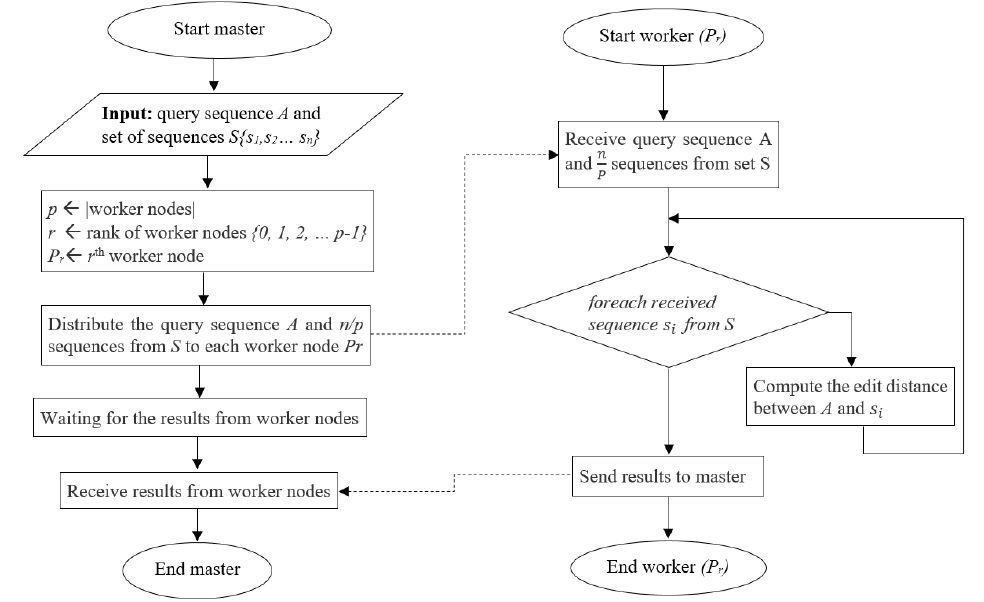
Figure 5. Flowchart of inter-task parallelism approach. The dotted lines show the communication between master and worker